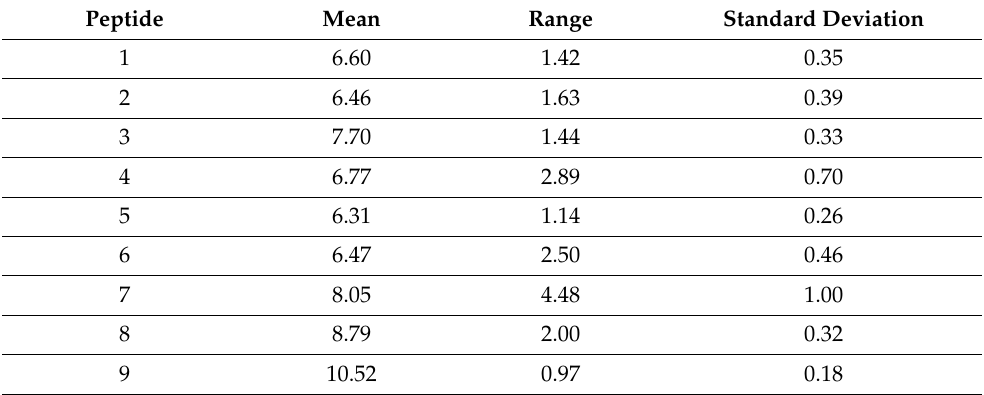
Figure 5. GnRH-I COM distance from the silica surface as a function time, starting from when all 9 peptides were adsorbed. The peptide traces are coloured as in Table 1. Table 2. Mean, range and standard deviation (all in Å) of the peptides’ COMs, measured for 100 ns after each peptide